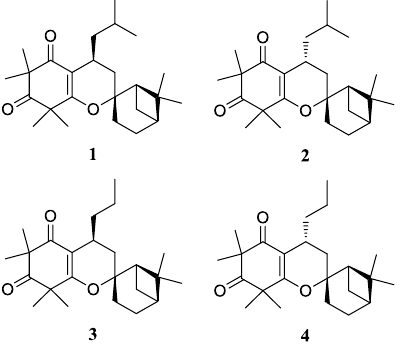
Figure 1. Structures of ficifolidione ( 1 ), its 4-epimer ( 2 ), and n -propyl derivatives ( 3 ) (4- S form), and ( 4 ) (4- R form) synthesized in our previous study [8].